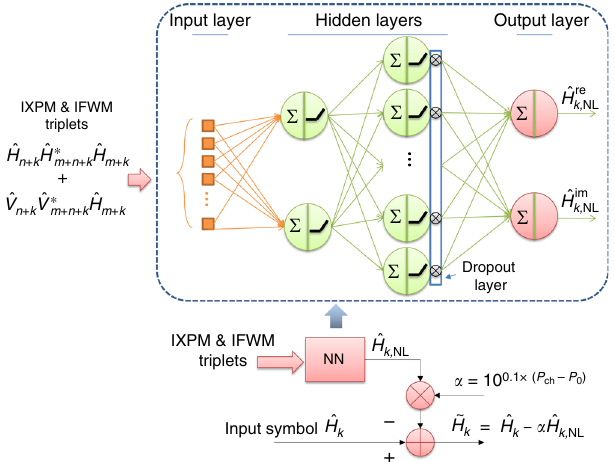
Fig. 4 The block diagram of the proposed NN-NLC. Illustrated for pol-x only. The diagram in the dashed box describes the optimized NN architecture with two hidden layers used in the paper